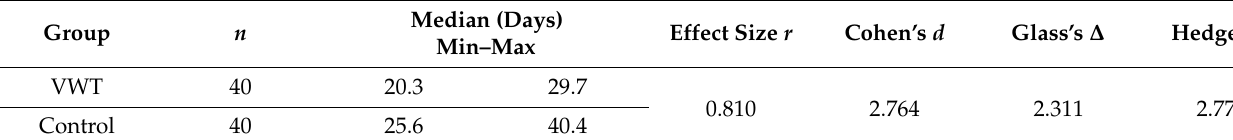
Table 3. Effect size of diabetic wound healing rate.